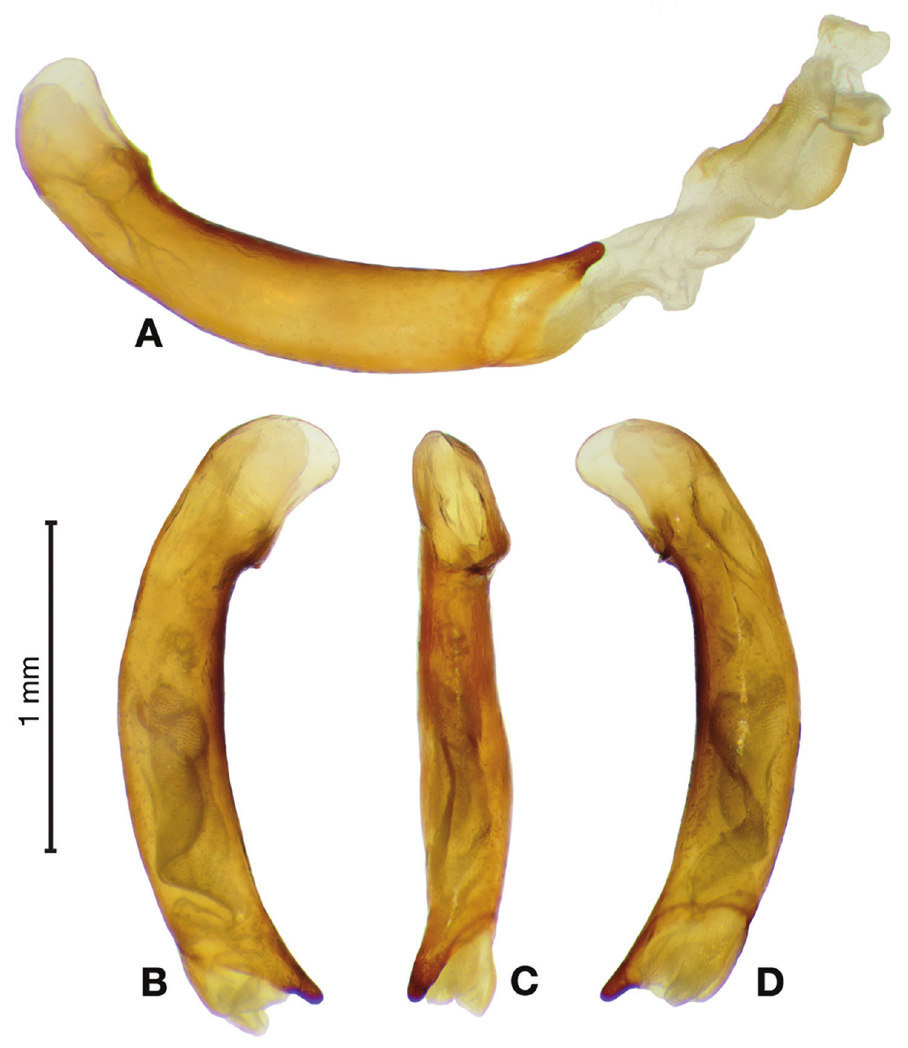
Figure 29. Digital images of male genitalia of Catascopus ( s. str. ) viridiorchis sp. n.. A right lateral aspect, endophallus everted B right lateral aspect C ventral aspect D left lateral